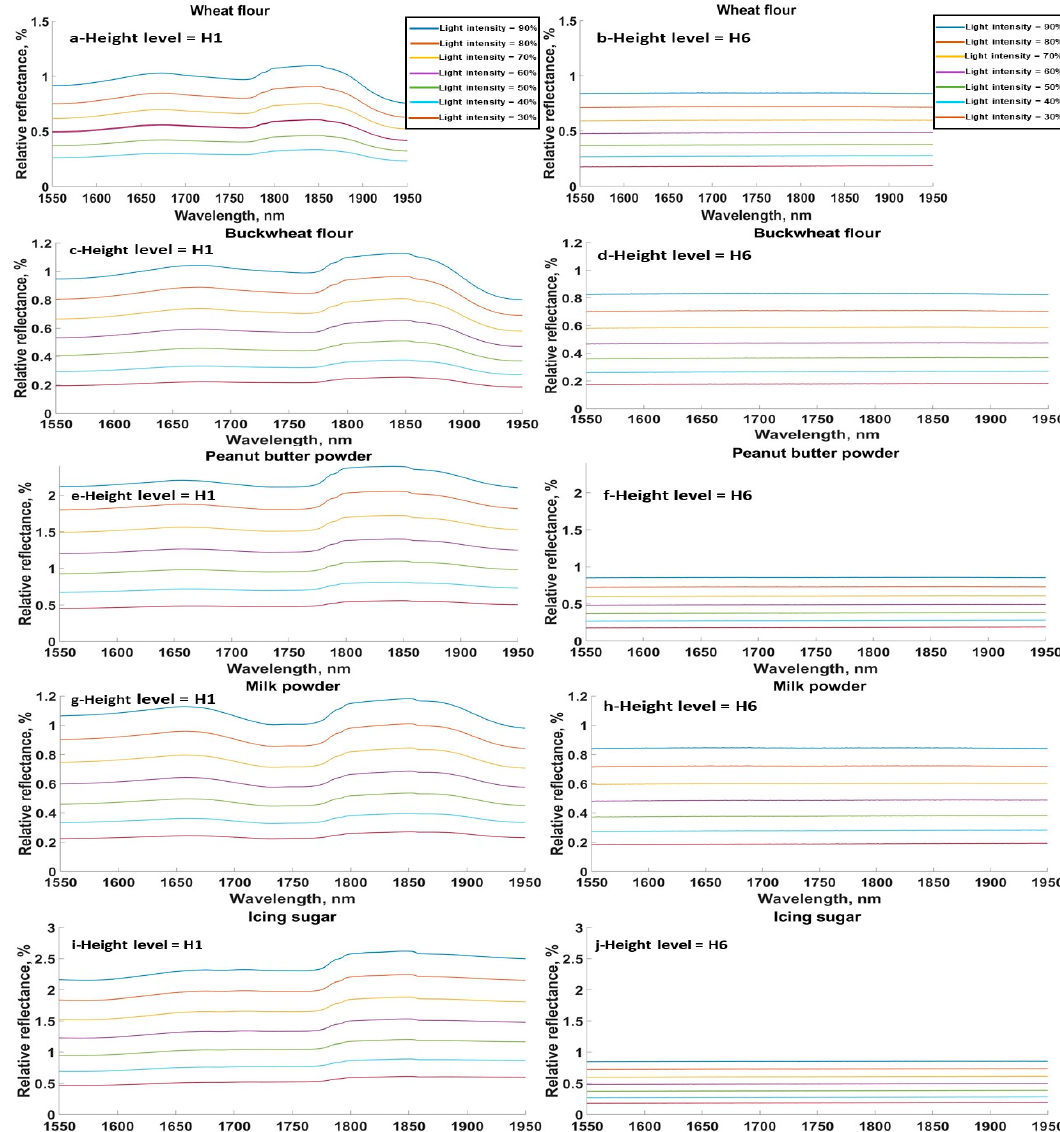
Figure 4. Relative reflectance for all light intensities and the minimum and maximum height levels, H1 and H6, for ( a , b ) wheat flour, ( c , d ) buckwheat, ( e , f ) peanut butter powder, ( g , h ) milk powder, ( i , j ) icing sugar.